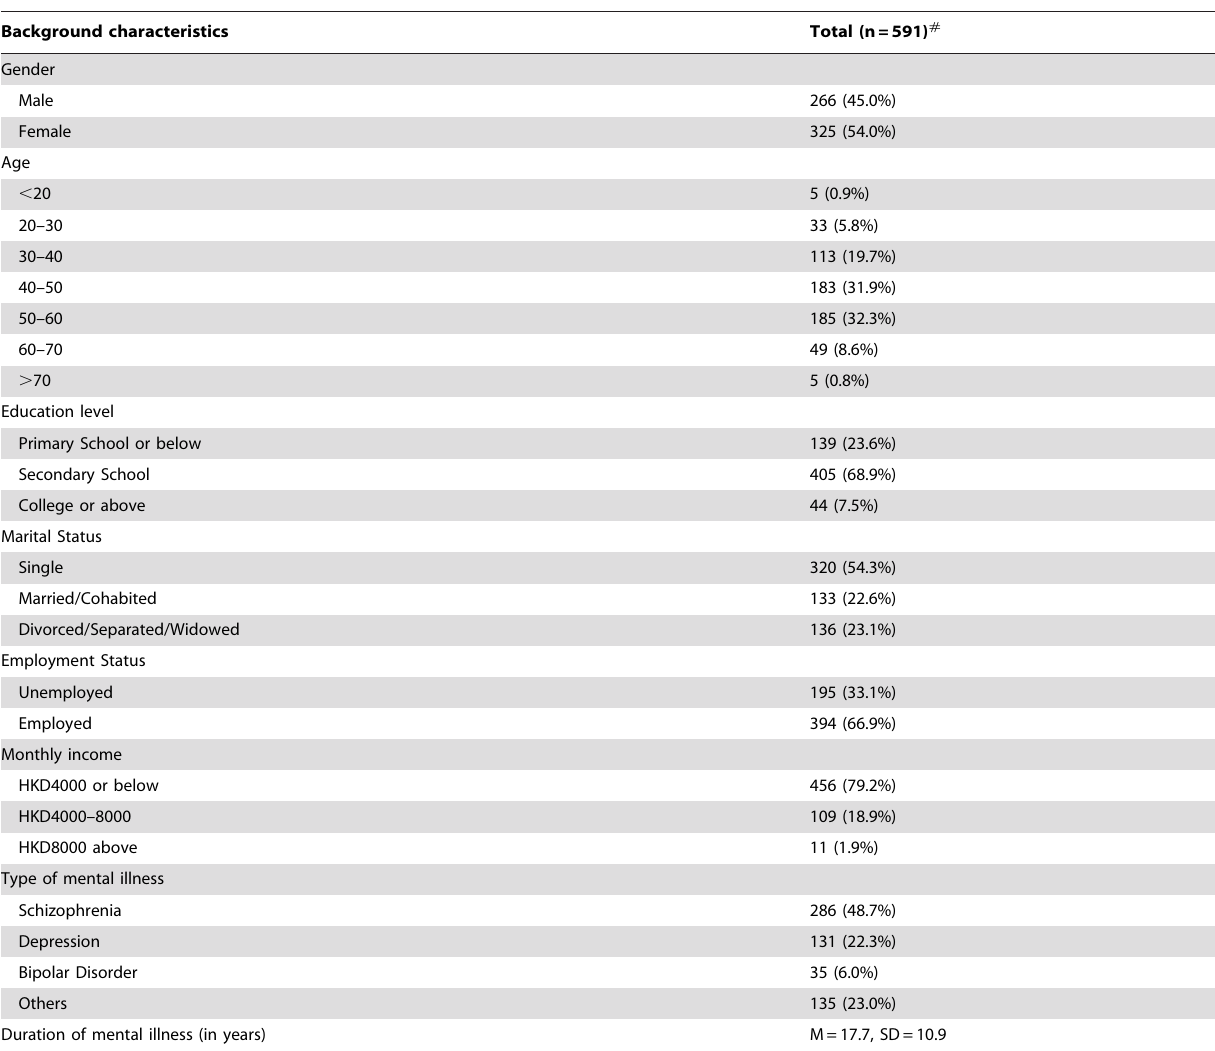
Table 1. Background Characteristics of the